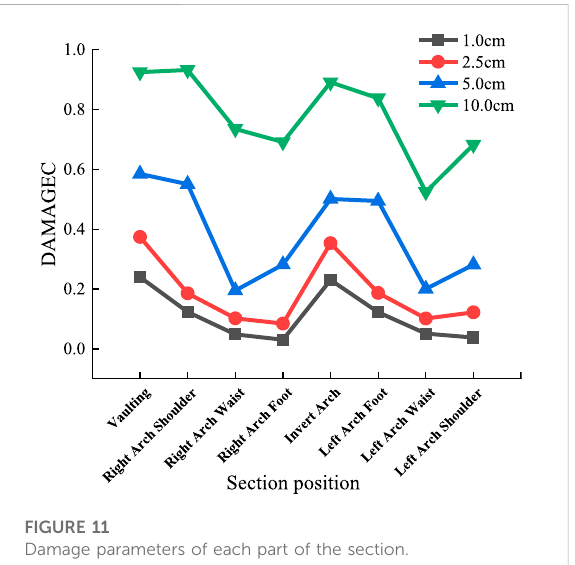
FIGURE 11 Damage parameters of each part of the